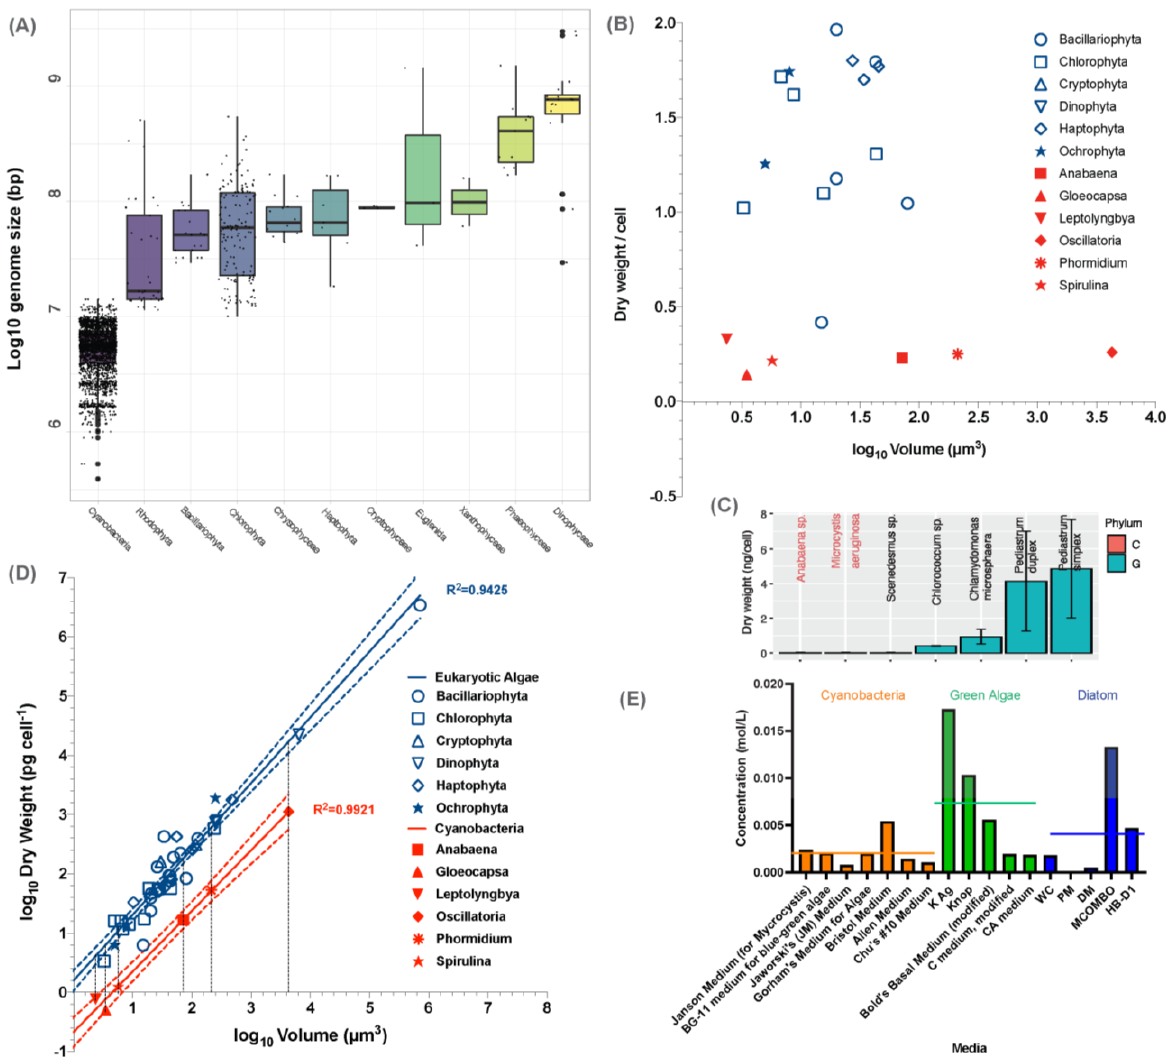
Figure 4. Comparison between cyanobacteria and eukaryotic algae in select key traits: ( A ) Distributions of log-transformed sequence length in eleven groups of algae. Summary statistics of 2240 genome assemblies were downloaded from NCBI Datasets: 1977 in cyanobacteria, 38 in Rhodophyta, 26 in Bacillariophyta, 156 in Chlorophyta, 14 in Chrysophyceae, 7 in Haptophyta, 3 in Cryptophyceae, 3 in Euglenida, 2 in Xanthophyceae, 11 in Phaeophyceae, and 20 in Dinophyceae, respectively. Each dot in the boxplot represents the log-transformed total sequence length of one assembly. ( B ) Distributions of dry weight per cell biovolume in Eukaryotic algae and cyanobacteria from the literature [68,69]. Each dot plot represents the average values of dry weight per unit biovolume and cell dry weights within a class. Blue symbols represent eukaryotic algae cells and red symbols represent cyanobacteria. ( C ) Relationship between cell volume (log 10 V , µm 3 ) and dry weight (log 10 DW , pg cell −1 ). Each dot plot represents the average values of cell volumes and cell dry weights within a class. Linear regressions were applied for eukaryotic algae (blue) and cyanobacteria (red) with 95% confidence intervals. ( D ) Lower nutrient requirements by cyanobacteria than eukaryotic algae in aquatic environment. Among seven selected media, the recipes of mAC, MJ, VTAC, and CHU-11 (left panel) are used for culturing green algae and the recipes of M11, BG11, and CT (right panel) are used for culturing cyanobacteria. ( E ): Lower nutrient requirements by cyanobacteria than eukaryotic algae in aquatic environment. Among seven selected media, the recipes of mAC, MJ, VTAC, and CHU-11 (left panel) are used for culturing green algae and the recipes of M11, BG11 and CT (right panel) are used for culturing cyanobacteria.